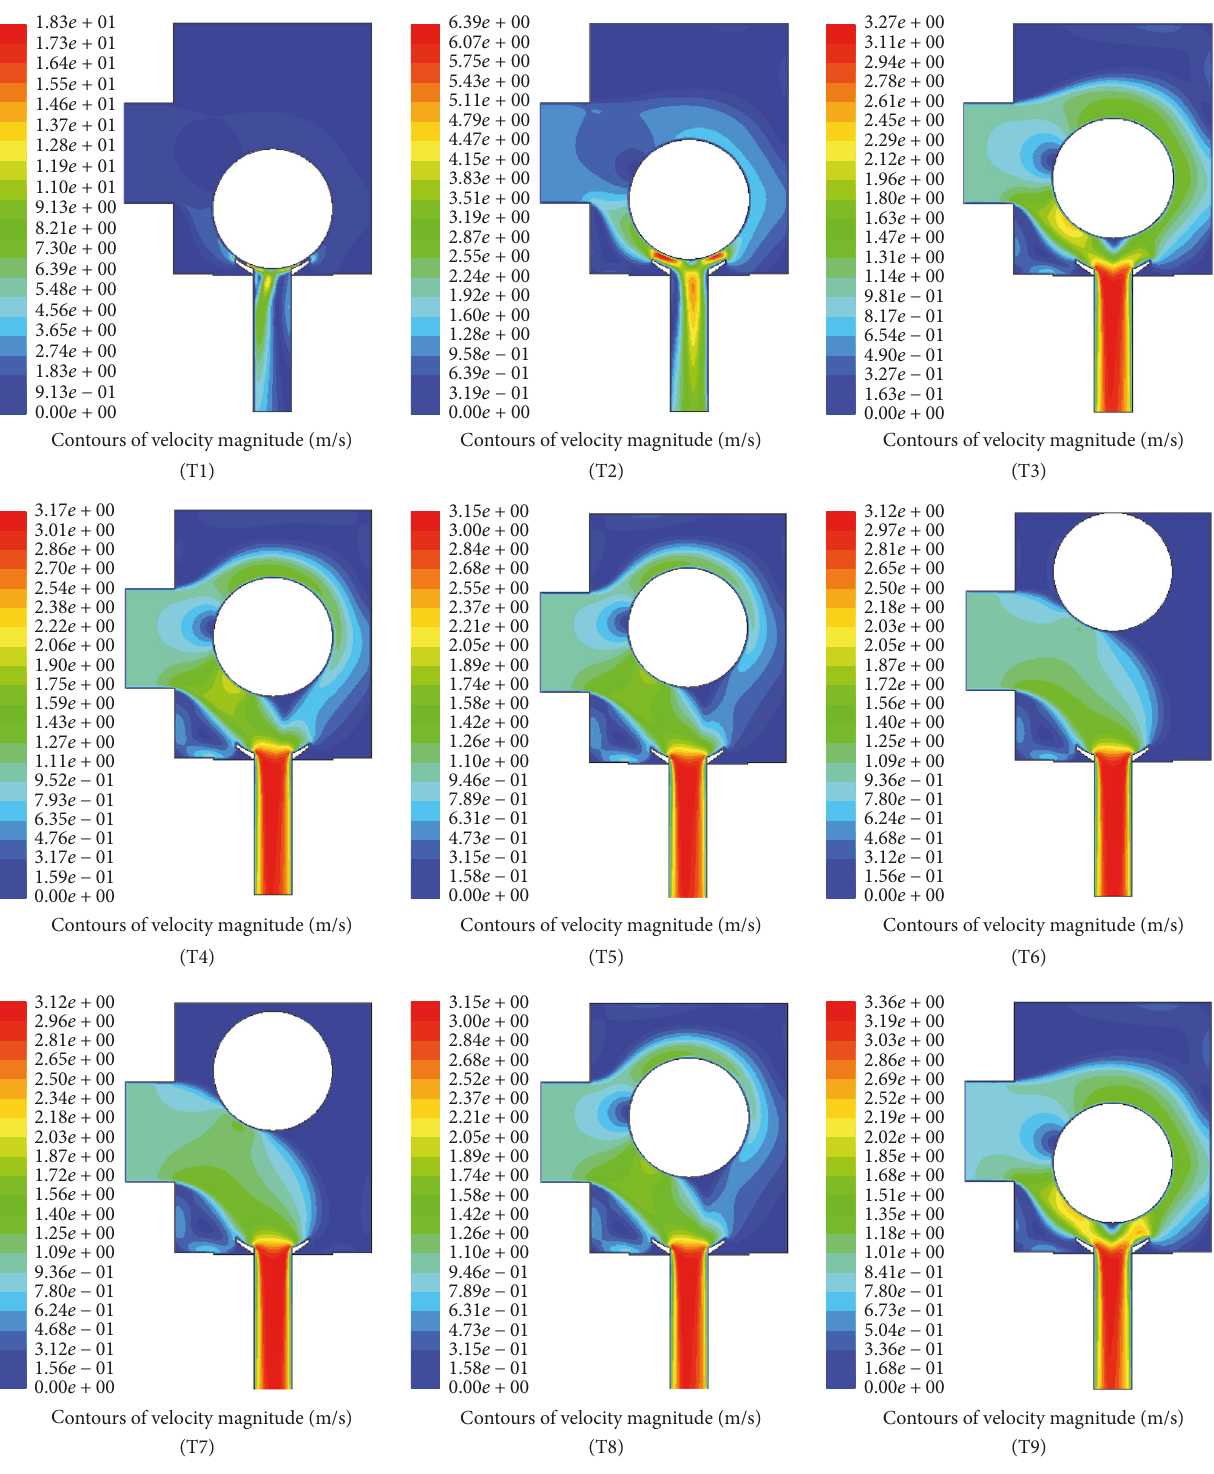
Figure 3: Contours of velocity magnitude during movement of floating